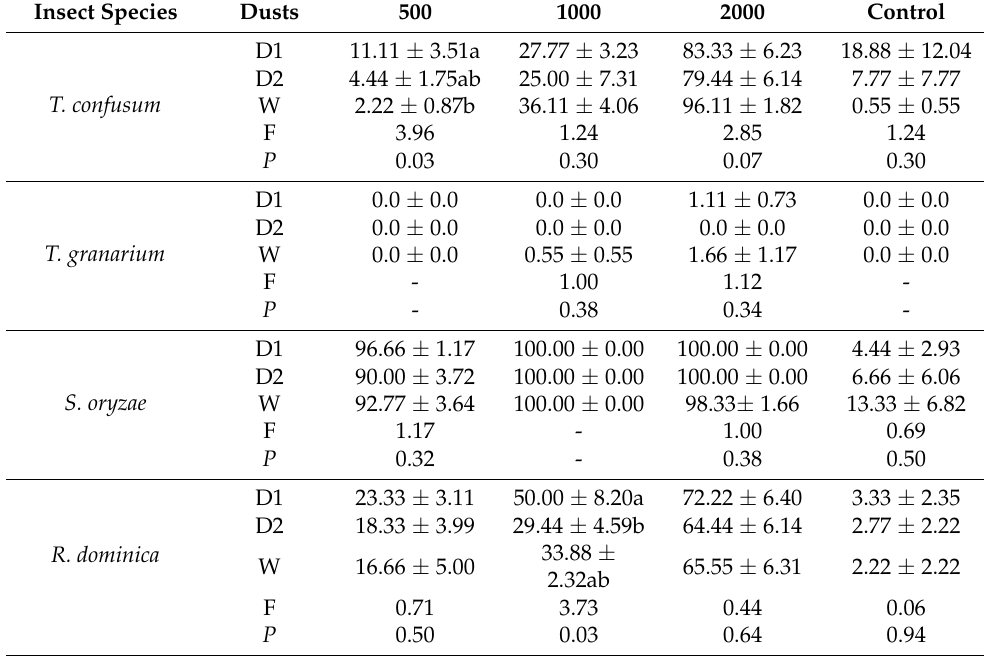
Table 5. Mean mortality (% ± SE) of Tribolium confusum , Sitophilus oryzae , Rhyzopertha dominica adults and Trogoderma granarium larvae after exposure to three different dust formulations (D1, D2, and W) applied at four concentration rates (500, 1000, 2000 ppm, and control) for Day 7 (in all cases df = 2.26).